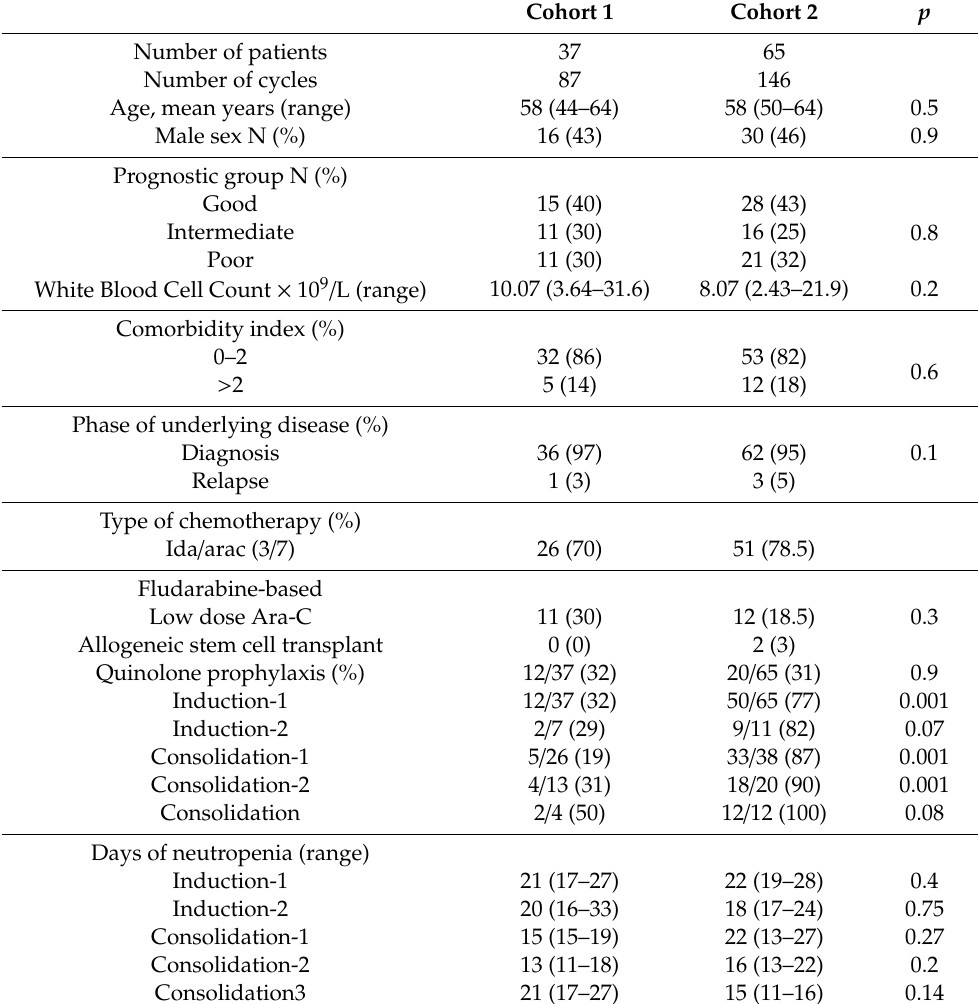
Table 1. Patients´ characteristics and univariate comparisons between cohorts. Data are expressed as number and percentage and as median and interquartile